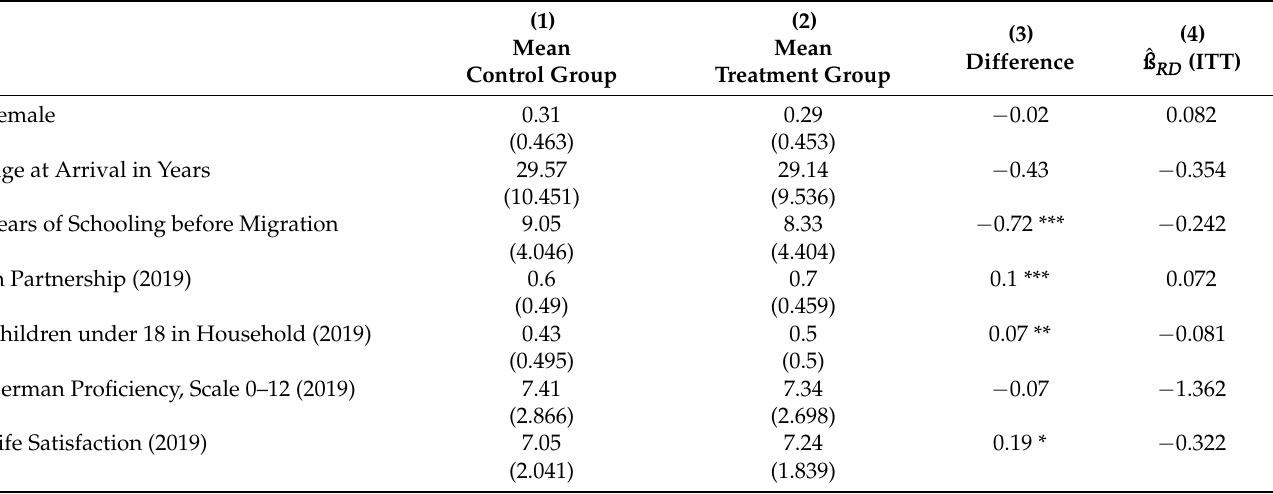
Table 1. Balancedness check for pre-treatment characteristics.